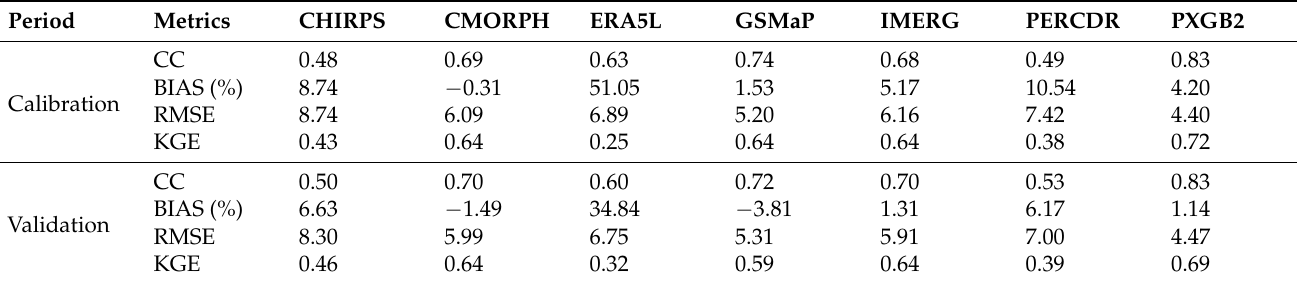
Table 4. The evaluation metrics of MSPs in calibration (2001–2004) and validation (2005–2006) periods. The unit of RMSE is